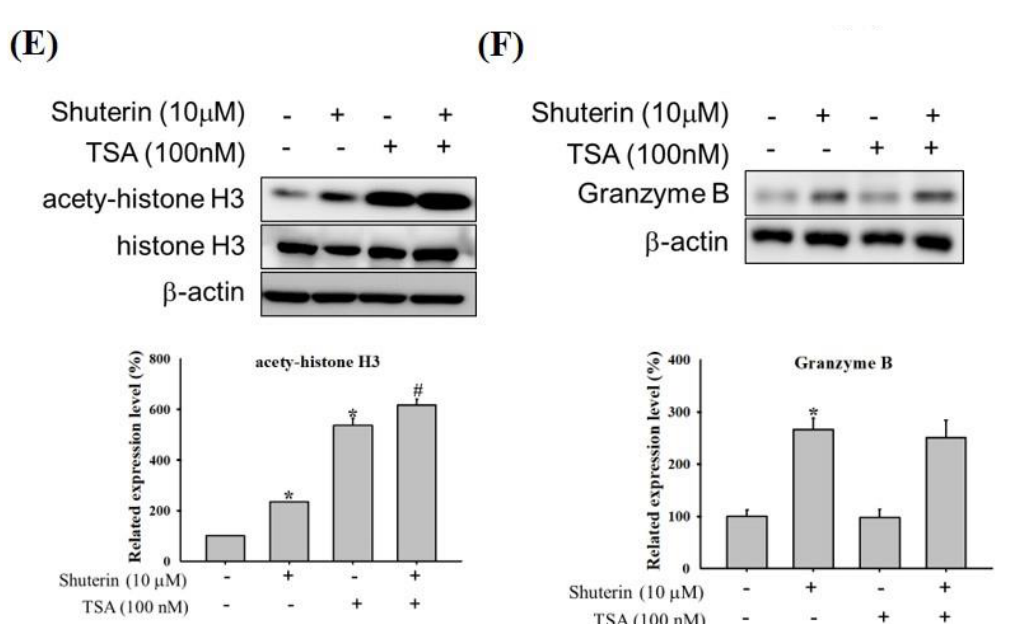
Figure 2. Shuterin increased the activated CREB and histone acetylation in KHYG-1 cells. The cells were treated with shuterin for 24 h. Protein levels of phosphorylated CREB/CREB ( A , B ) and acetyl-histone H3/histone H3 ( C , D ). KHYG-1 cells were pretreated with TSA for 1 h or left untreated; subsequently, the cells were treated with shuterin for 24 h. Protein levels of acetyl-histone H3/histone H3 ( E ) and granzyme B ( F ). Protein levels were determined using densitometry and normalized to beta-actin levels. Data are presented as the mean ± standard deviation (n = 3). * p < 0.05 V.S. control, # p < 0.05 V.S. TSA alone. CREB, cyclic adenosine monophosphate response element–binding protein; TSA, trichostatin A.